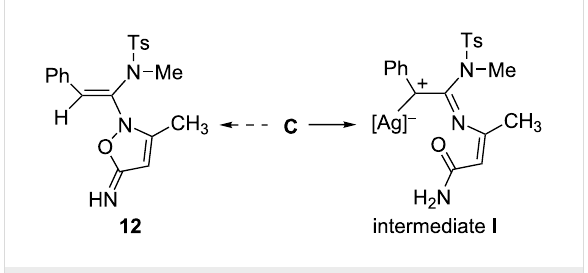
iminium ion intermediate B . A nucleophilic addition of